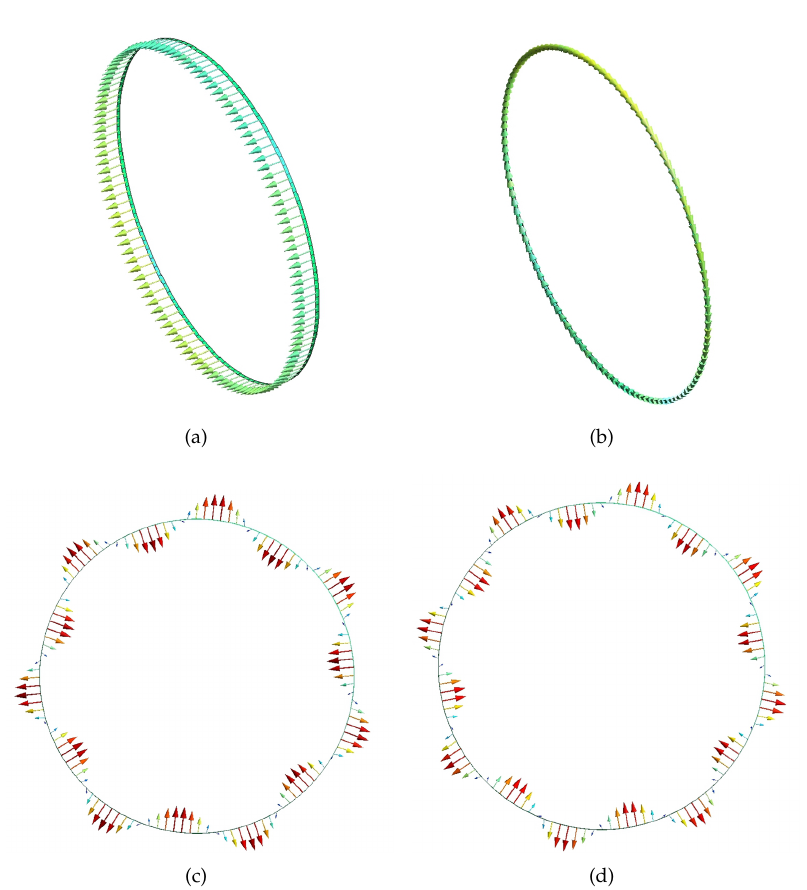
Figure 9. Wave-shapes calculated by WFEM at 1000 Hz shown in Gmesh: ( a ) L 0 ; ( b ) T 0 ; ( c ) F 7 ; ( d ) F 8 . Please note that the waves are coupling in three directions, especially near the cutoff